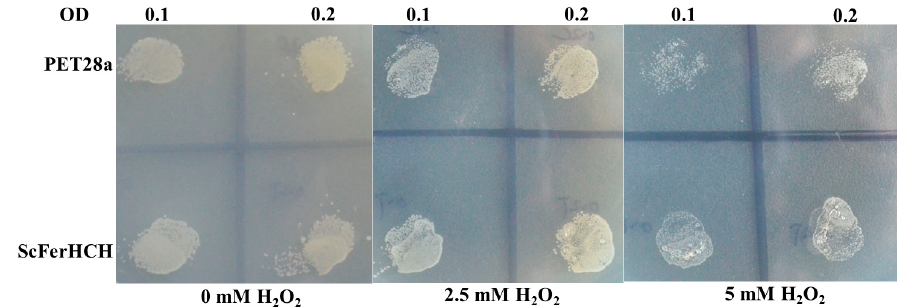
Figure 8. H 2 O 2 tolerance of BL21 (DE3) E. coli containing the pET28a vector expressing recombinant ScFerHCH protein. Serial dilutions of cells were plated on LB agar containing different concentrations of H 2 O 2 and incubated for 12 h at 37 °C.